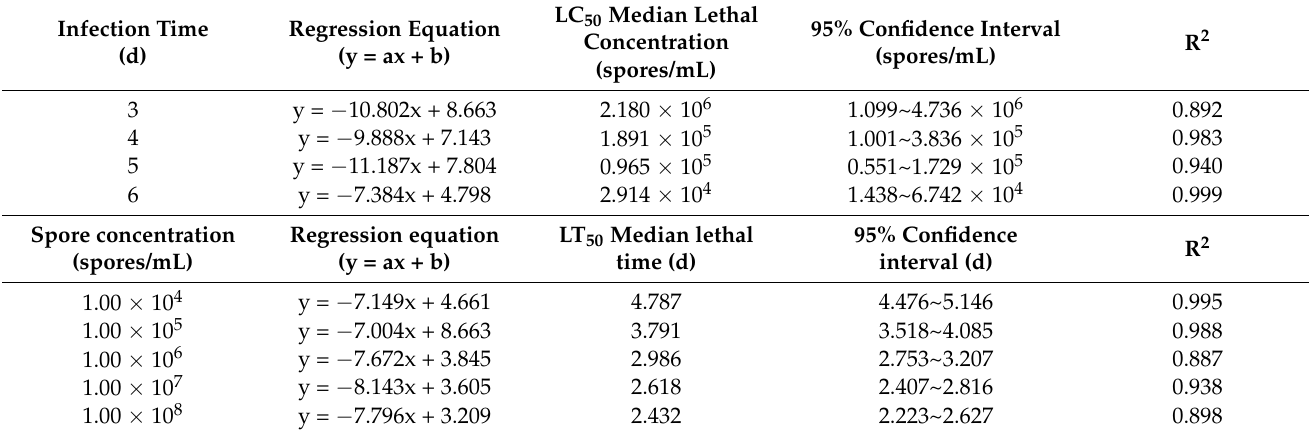
Table 1. Pathogenicity of M. hiemalis BO-1 against B. odoriphaga 4th-instar